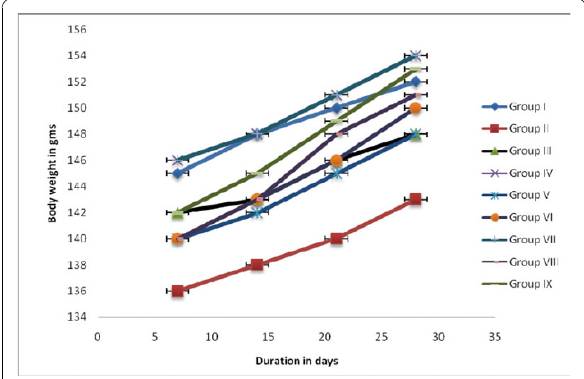
Figure 1 Relationship between the extent of joint inflammation and the degree of weight